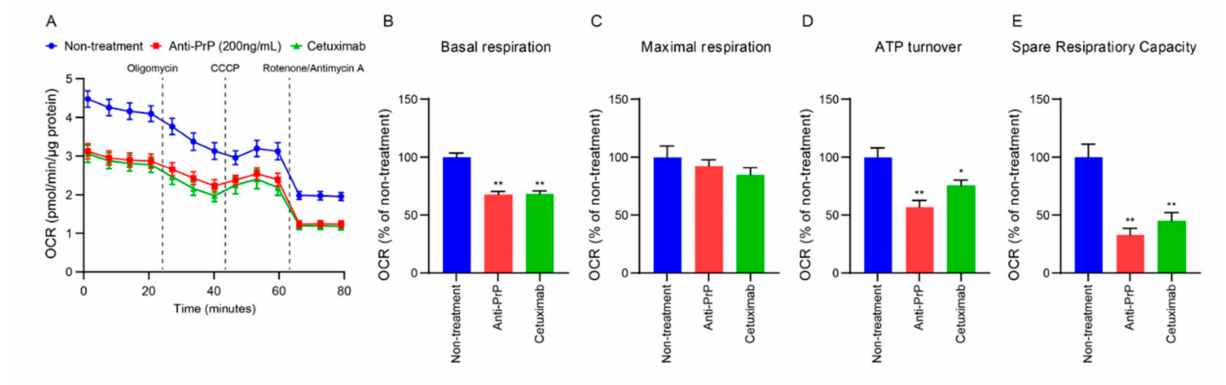
Figure S12. Mitochondrial respiration in CRC cells after treatment with anti-PrP antibody and cetuximab. * p < 0.05, ** p < 0.01. The authors state that this correction does not modify the scientific results of the study. The authors would like to apologize for any inconvenience caused by this mistake. Conflicts of Interest: The authors declare no conflict of